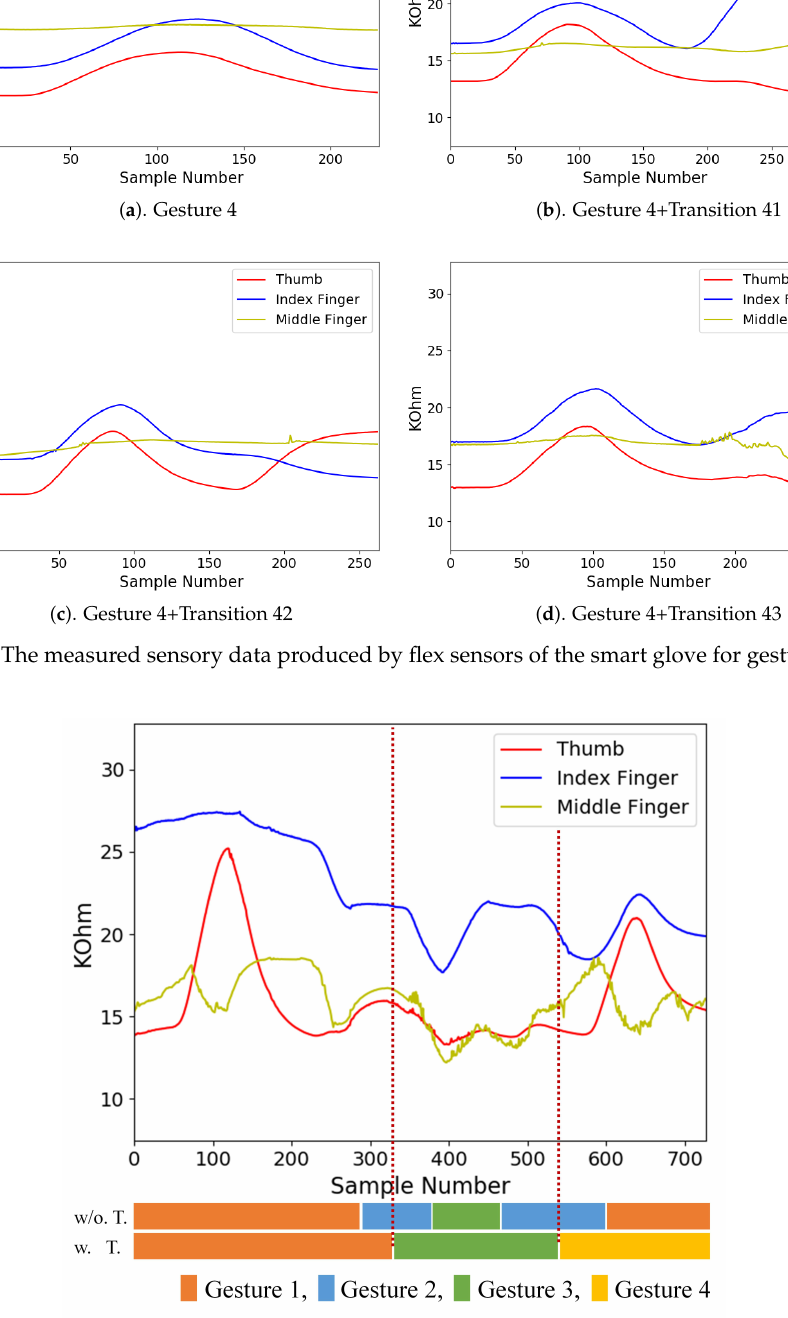
Figure 18. An example of a testing sequence produced by flex sensors consisting of three finger gestures (Gesture 1, Gesture 3, Gesture 4) back to back. The results of gesture spotting with and without the inclusion of transitions for training are shown at the bottom. The w. T. and w/o. T. denote the training operations with and without transitions,